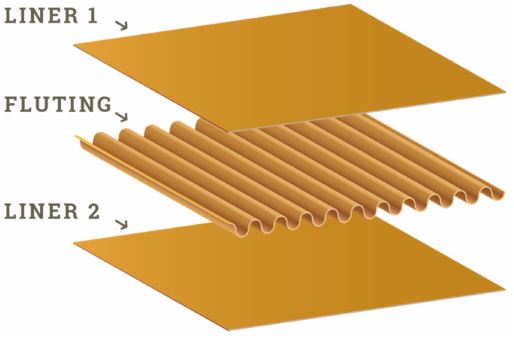
Figure 1. The structure of corrugated board